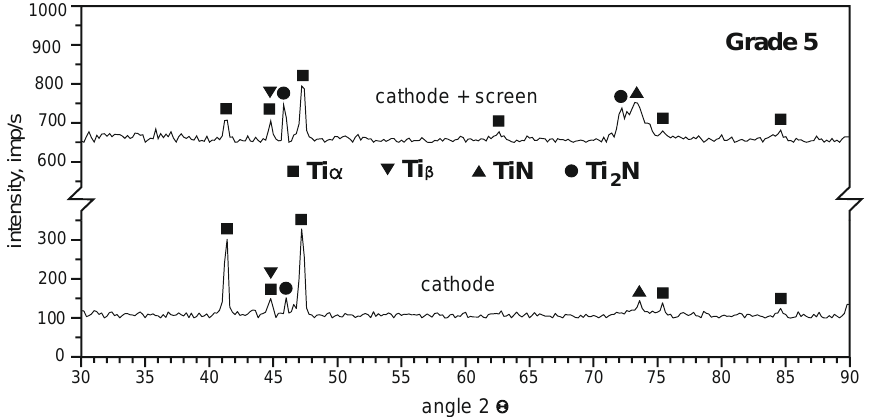
Figure 11. Diffractograms of the layer nitrided on the substrate of Grade 5 titanium alloy after various variants of ion nitriding, process temperature T = 530 °C, process time t = 17 h.